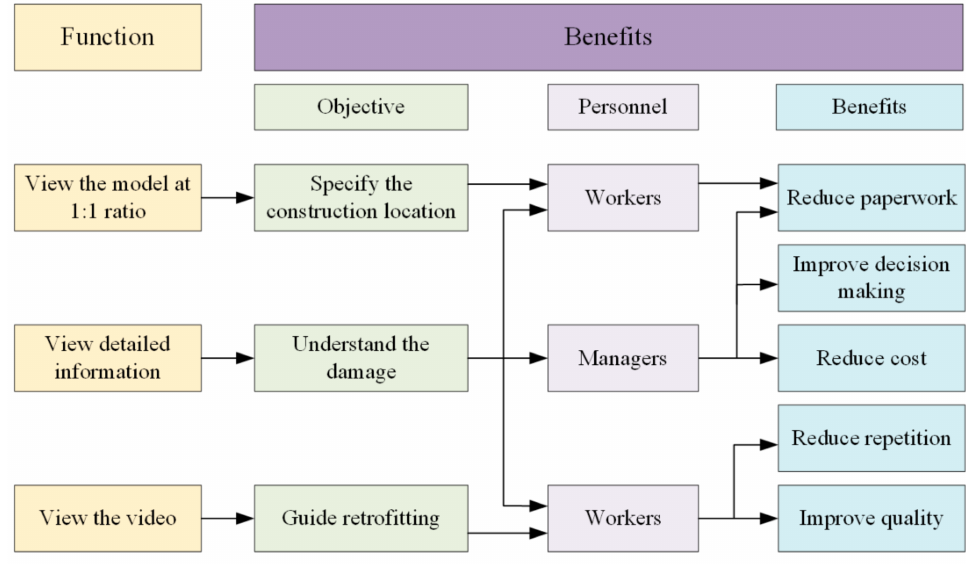
Figure 10. Benefits of the proposed